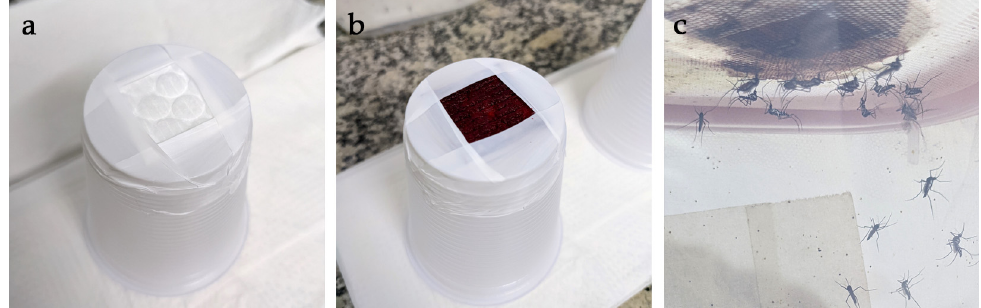
Figure 1. Artificial blood feeding. ( a ) cotton pad secured to the base of a plastic feeding cup with Teflon tape; ( b ) feeding cup after the application of blood; and ( c ) Hg. janthinomys feeding on a cup inverted over the top of a cage and partially filled with 45 ◦ C